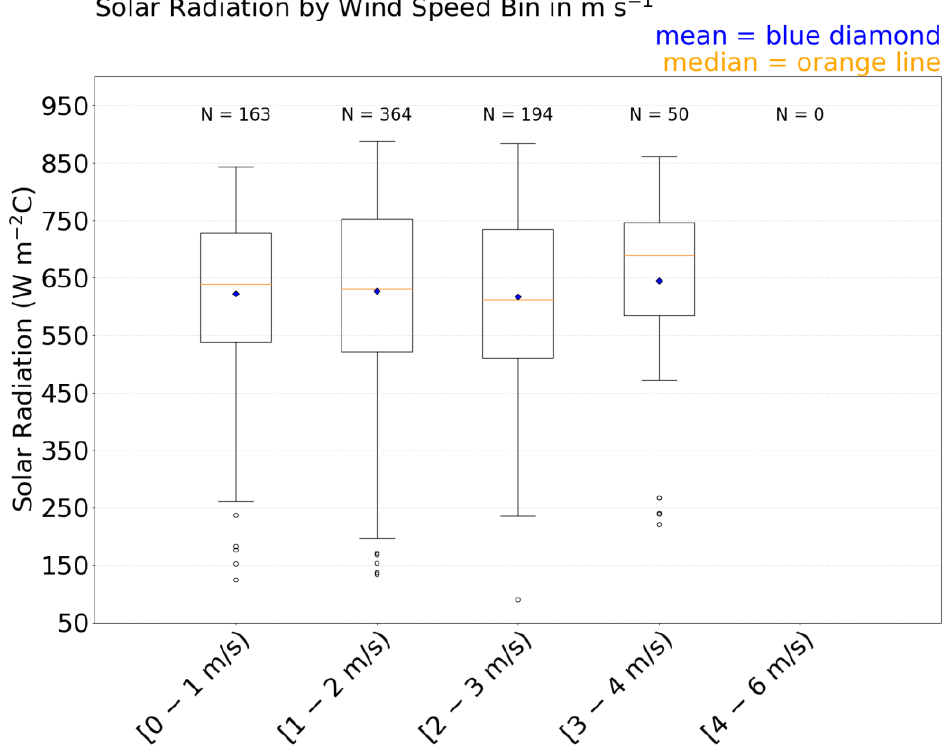
Figure 8. Side-by-side boxplots of solar radiation (W m − 2 ) by 1 m s − 1 wind speed bin, for the day-time Tower experiments (i.e., dusk experiments excluded). Sample size (N) for each bin is given above each boxplot.